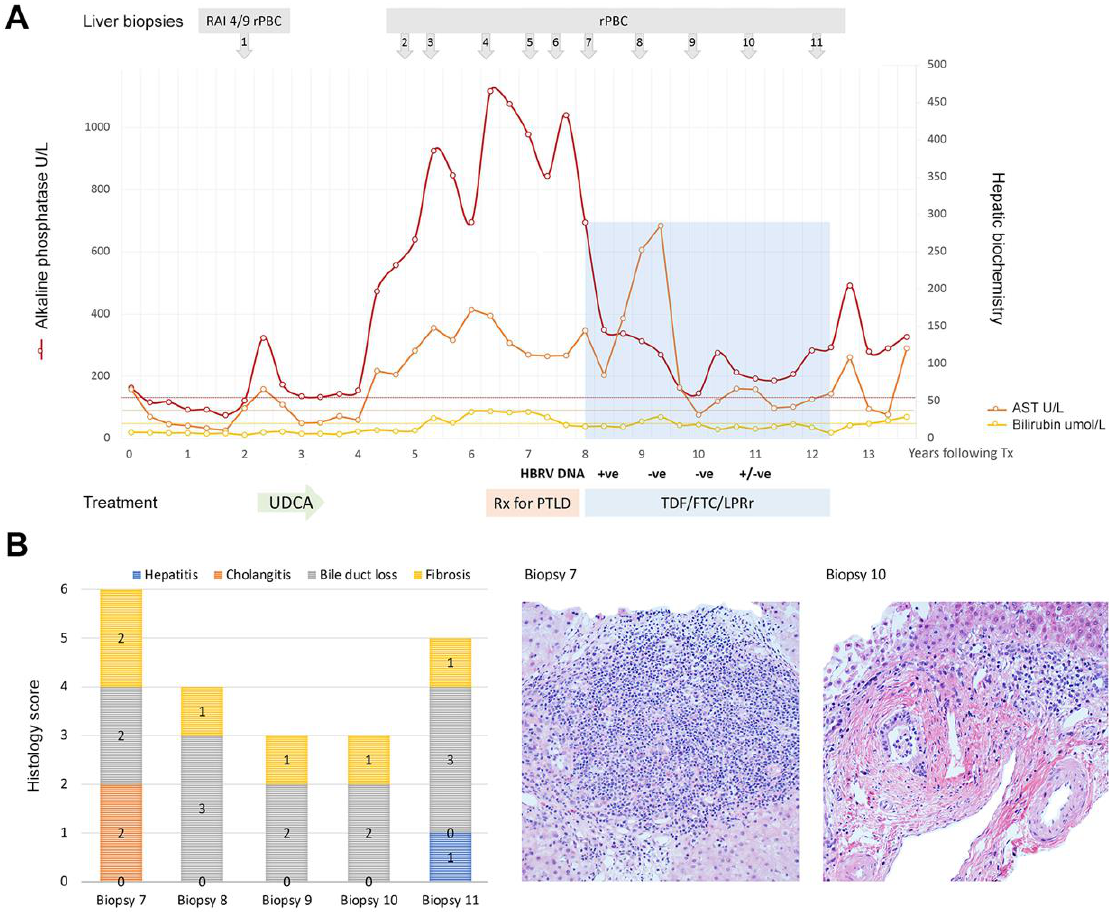
Figure 1. Attenuation of cholangitis by combination ART to treat recurrent PBC following liver transplantation. ( A ) A 21-year-old female developed histological and biochemical evidence of recurrent PBC (rPBC) with mild rejection (RAI: rejection activity index 4/9) within 3 years of liver transplantation. This was treated with ursodeoxycholic acid (UDCA) to accompany her immunosuppression of tacrolimus and mycophenolic acid. Following partial biochemical resolution, her cholangitis worsened, and she developed EBV viremia, mandating a reduction in immunosuppression and use of valganciclovir. She developed post-transplantation lymphoproliferative disorder (PTLD) with an aggressive diffuse large B-cell lymphoma. She was treated with methotrexate, Ara-C, hydrocortisone, and Rituximab, which resulted in severe biochemical cholangitis. She was found to be positive for HBRV DNA in whole blood and following discussions with the patient and liver transplant committee, the patient commenced combination ART with FTC/TDF 200/300 mg and LPV/r 800/200 mg (shaded in blue). ( B ) Prior to the commencement of cART, there was histological evidence of progressive disease with fibrosis, ductopenia and cholangitis (biopsy 7), and cART was associated with a marked reduction in cholangitis and interface hepatitis (biopsy 10). She experienced a marked reduction in alkaline phosphatase with cART, but this was also associated with marked biochemical hepatitis and inhibition of tacrolimus metabolism. Four years after commencing antiviral treatment (year 12), the patient found it difficult to swallow large tablets because of sensory neuropathy and discontinued cART therapy. More recently, the patient commenced a new regimen with TDF/FTC/RAL with a similar biochemical response. (The serial biopsies are numbered and were evaluated for hepatitis, cholangitis, ductopenia and fibrosis using a modified Nakanuma score [9]; liver biopsies were stained with hematoxylin and eosin and are shown with a magnification 400 × . Adapted from [8] with